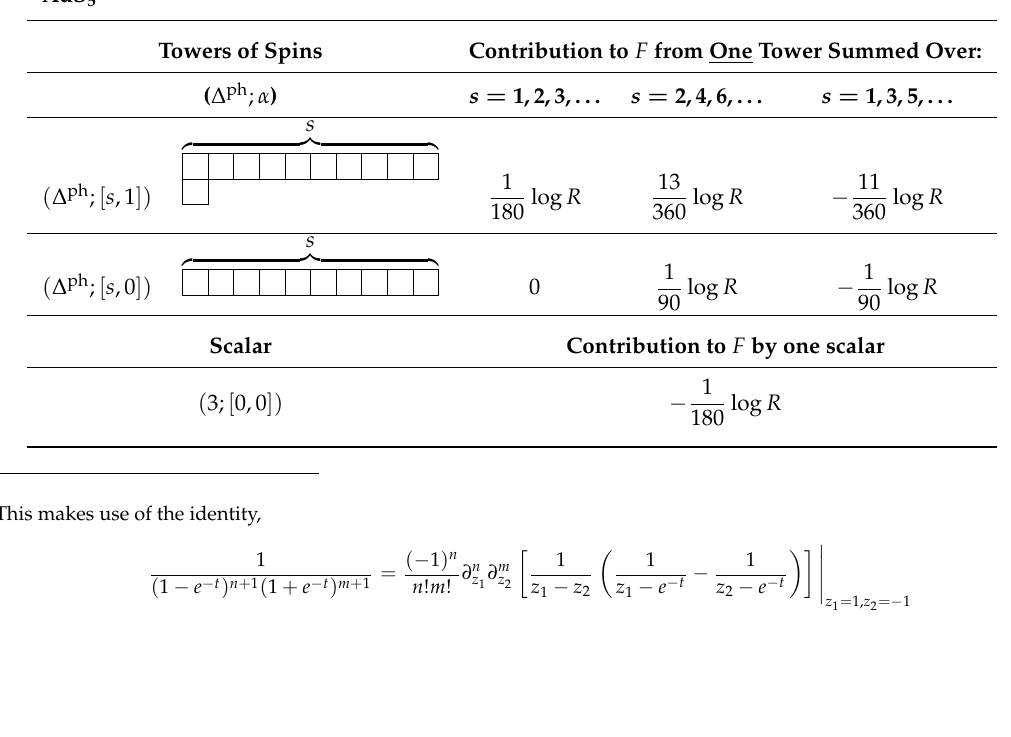
Table A3. Results for Type B theory in AdS 5